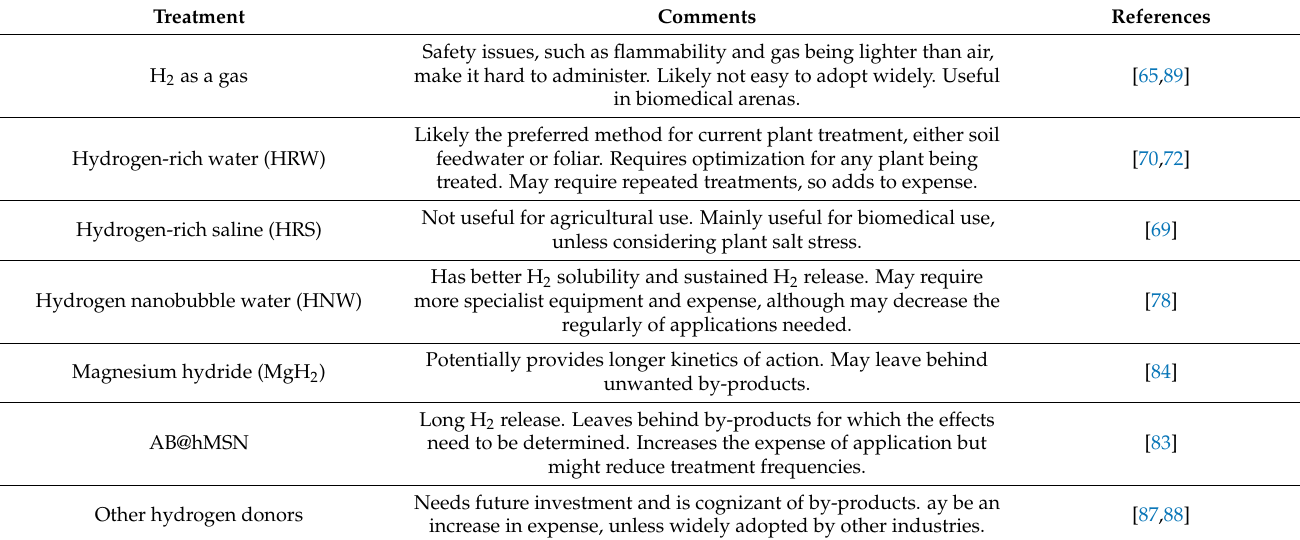
Table 1. A summary of treatments which may be of potential use in future UK agriculture.